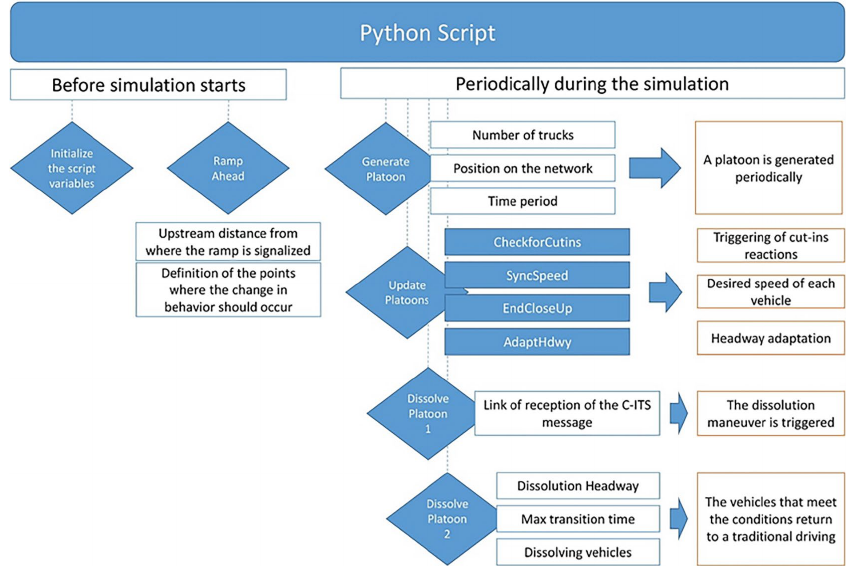
Figure 1. Script